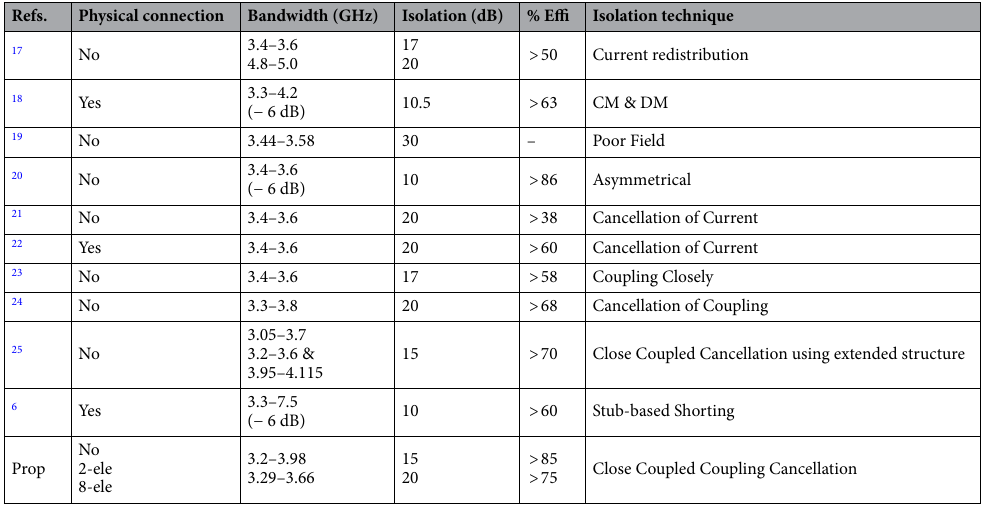
Table 3. Comparison with related